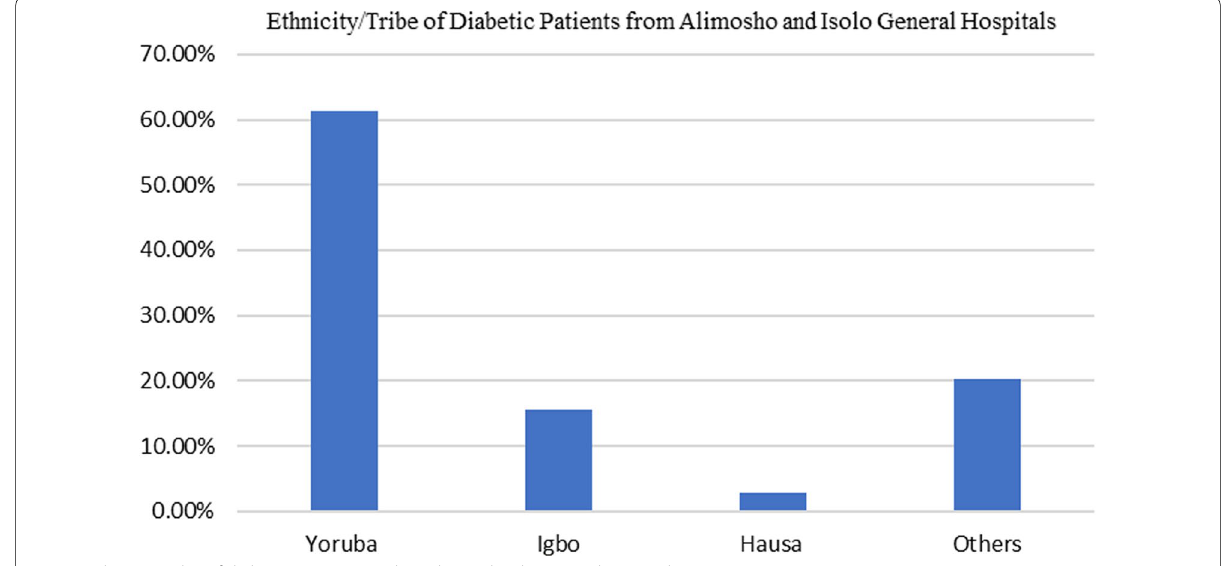
Fig. 4 Ethnicity/tribe of diabetic patients in Alimosho and Isolo General Hospitals